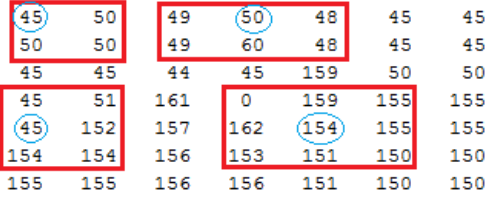
Figure 7. Neighbors of each